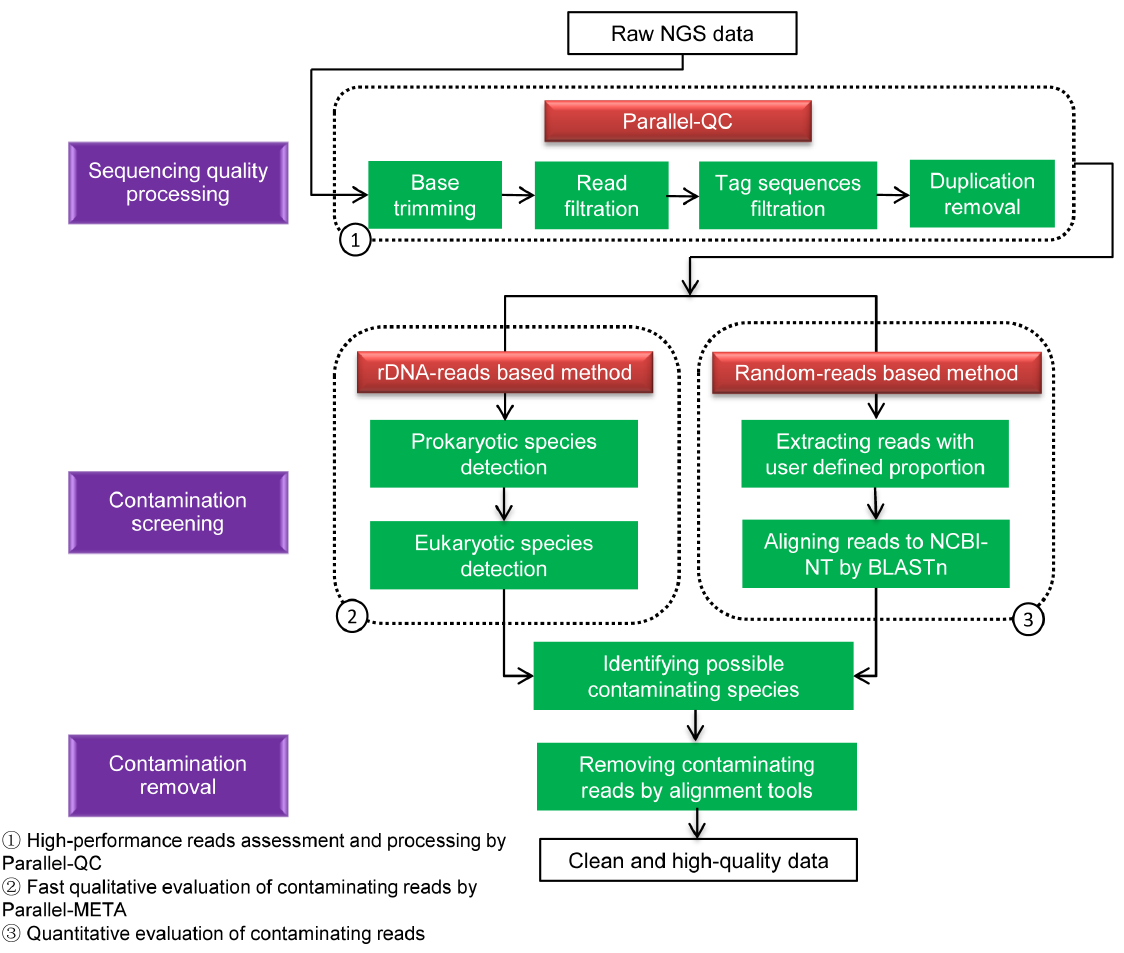
Figure 1. The overall workflow of QC-Chain.